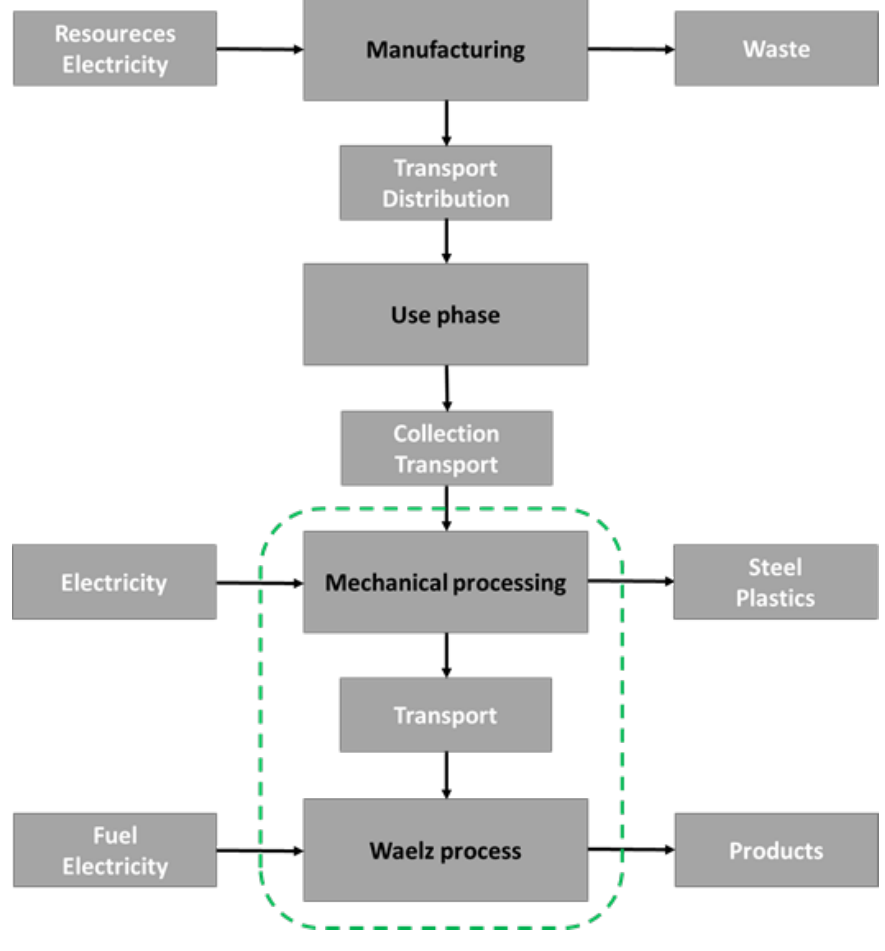
Figure 2. System